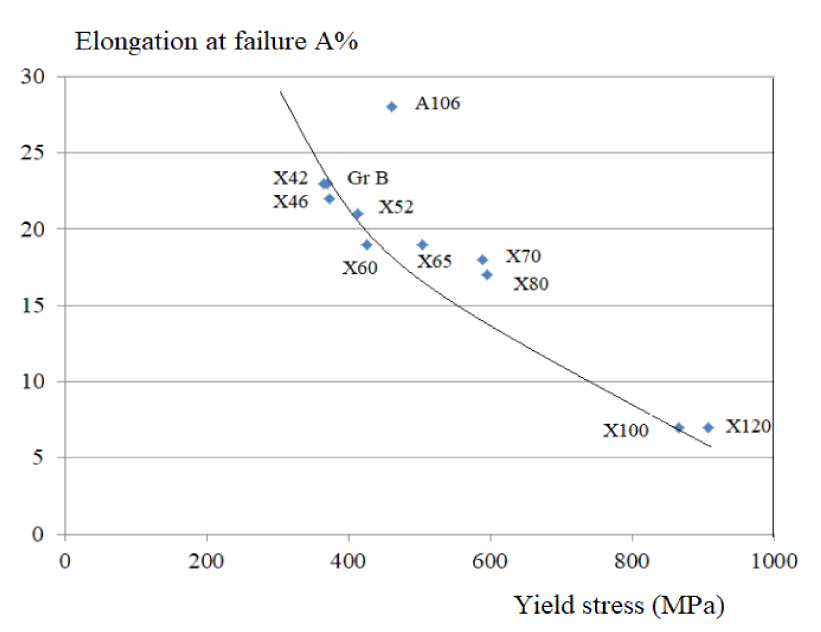
Figure 4. Failure elongation ratio of pipe steels after HE versus yield stress.